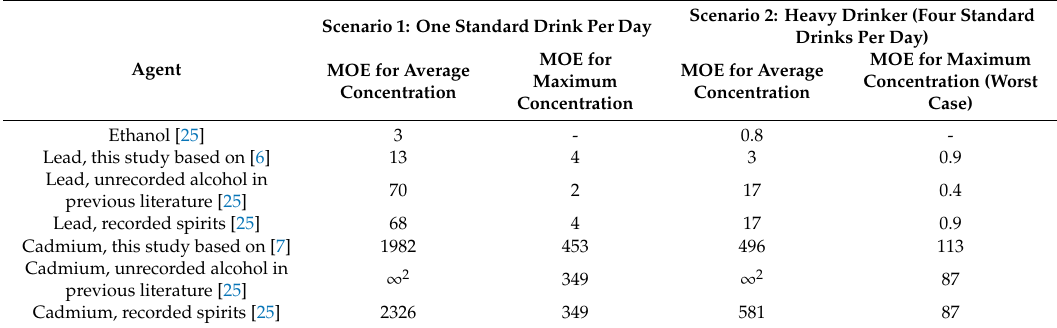
Table 1. The margin of exposure (MOE) 1 of ethanol, lead and cadmium in unrecorded alcoholic beverages calculated for di ff erent drinking and contamination scenarios. Scenario 2: Heavy Drinker (Four Standard Scenario 1: One Standard Drink Per Day Drinks Per Day) MOE for Maximum MOE for Agent MOE for Average MOE for Average Concentration (Worst Maximum Concentration Concentration Concentration